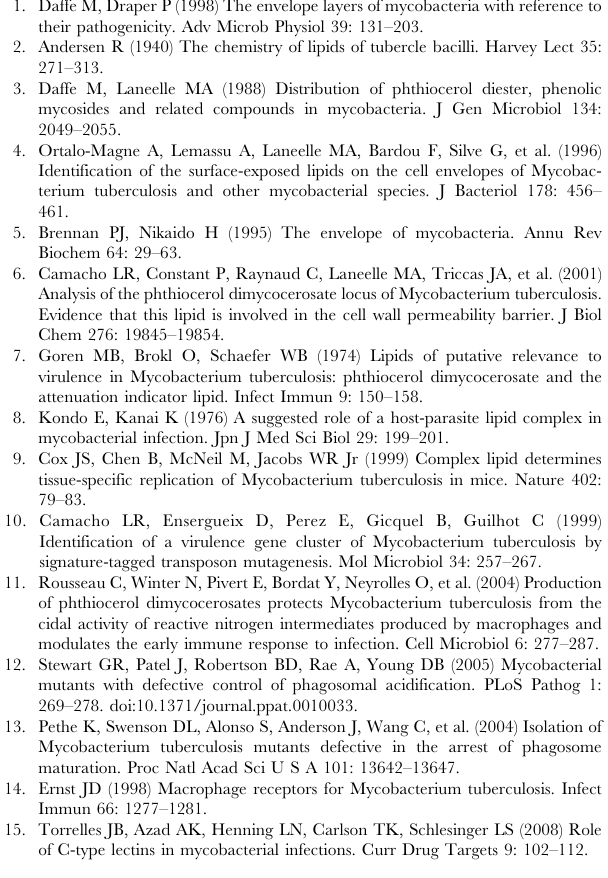
Figure S1 Thin Layer chromatography analysis of DIM extracted from H37Rv, DIM-less mutants, and complemented strains. Lipids were labelled using [1-14C] propionate, extracted, and analyzed as described previously [48]. Three major bands were visible corresponding to three structural variants of DIM (dimycocerosates of phthiocerol, forms A and B, and dimycocer- osates of phthiodiolone) [3]. These DIM were all missing in the PMM56, PMM100, PMM50, and PMM97 mutants. (A) TLC analysis of lipids extracted from the various M. tuberculosis WT and recombinant strains. (B) TLC analysis of lipids extracted from the various M. bovis BCG, WT and recombinant strains. (C) TLC analysis of DIM extracted from lived or heat-killed M. tuberculosis . Lipids were labelled using [1-14C] propionate, and half of the bacteria was heat-killed using the same conditions as the ones used for evaluation of acidification of Mtb -containing phagosome.